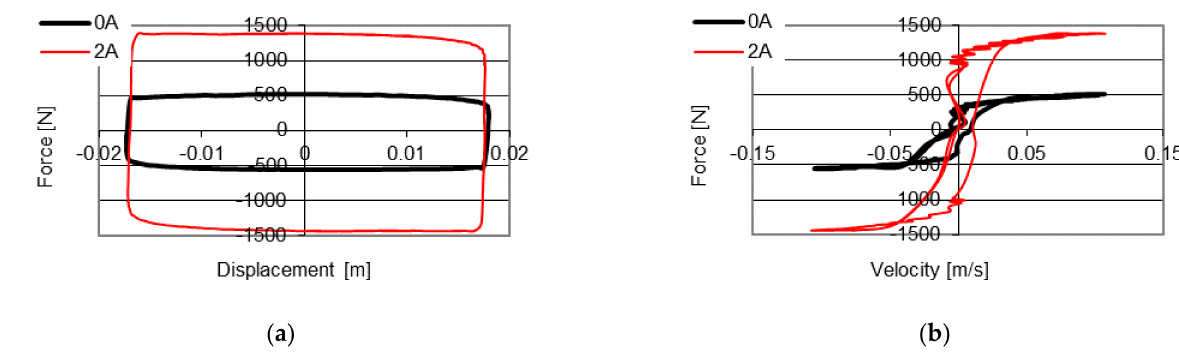
Figure 2. Dissipative characteristic of the MR-IP damper, ( a ) plane: force–displacement, ( b ) plane: force–velocity.